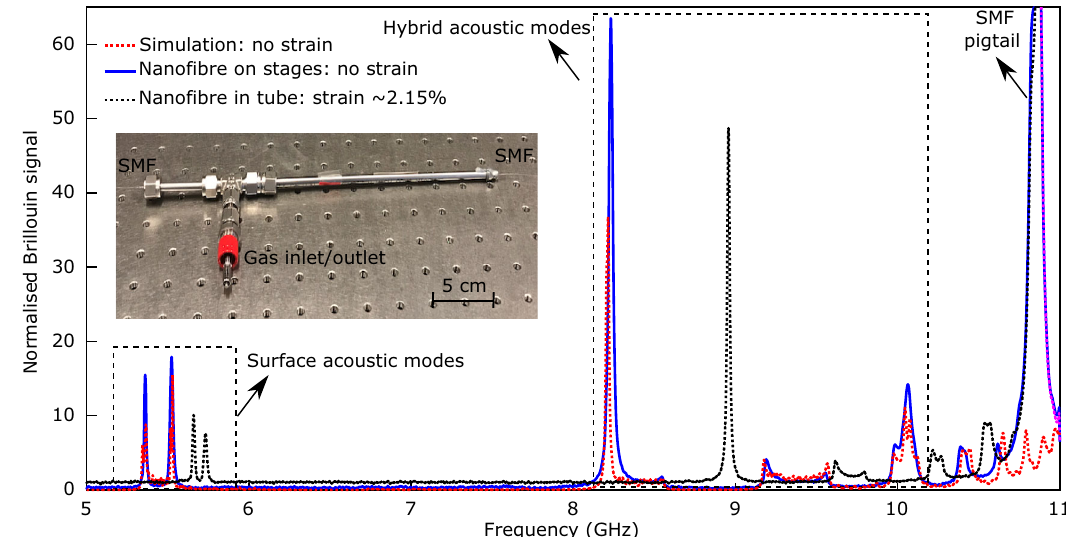
Fig. 3 Backward Brillouin scattering in the silica material of the nano fi bre during fabrication process. The backward Brillouin scattering of the nano fi bre is measured with a set-up we developed in 2017 37 . The Brillouin signal is normalised to the background noise of the electrical spectrum analyser when there is no pump. The Brillouin spectra from the surface acoustic modes and the hybrid acoustic modes of the silica nano fi bre during fabrication are calculated by the model in 37 . The blue line shows the measured Brillouin spectrum of the nano fi bre on the stages after tapering. The dotted red line shows the simulated Brillouin spectrum of the nano fi bre with a waist diameter of 740 nm. The dotted black line shows the measured Brillouin spectrum of the nano fi bre after packaging the nano fi bre in a metallic tube with a 2.15% strain. Note that the signal from SMF pigtail is not taken into account in the simulation and any response from interactions in the gas is not visible in the frequency range covered by the set-up. The Brillouin scattering from the standard single-mode fi bre pigtail of the nano fi bre is also observed at a frequency of 10.86 GHz. The inset shows the fabricated nano fi bre gas cell with the untapered SMF segments exiting the gas cell at each end. Gases can be pressurised in or vacuum pumped out through the gas inlet/outlet